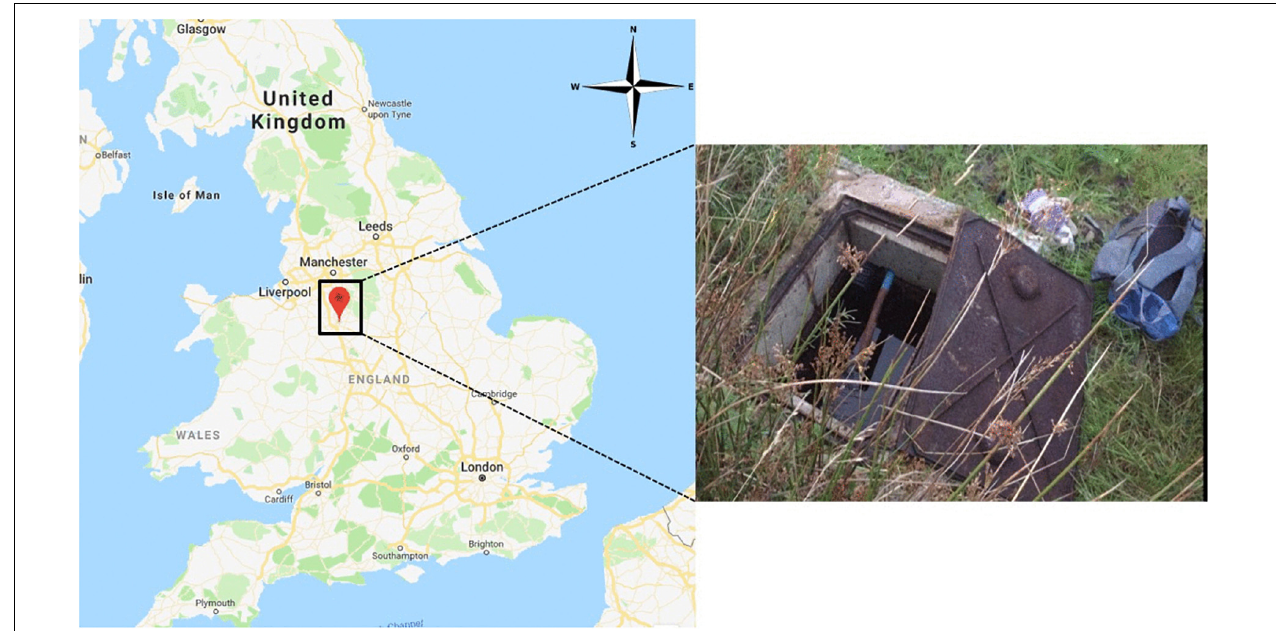
FIGURE 1 | Spring water sampling site at a private spring in the West Midlands, United Kingdom.